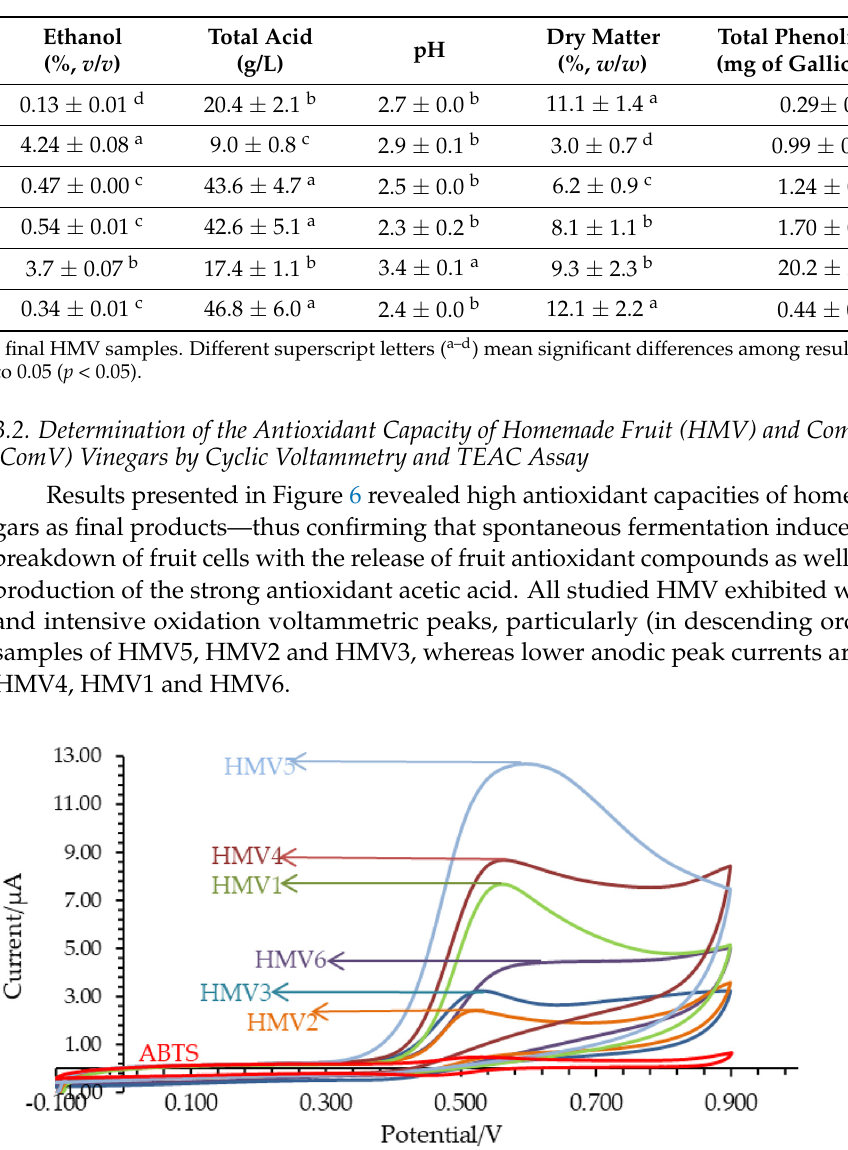
Table 1. Chemical composition of final homemade fruit vinegars (HMV) after two months (60 d) of fermentation, for ethanol content (% v / v ), total titratable acids (g/L), pH and dry matter (%, w / w ): apple vinegar (HMV1); raspberry vinegar (HMV2); blueberry vinegar (HMV3); blackberry vinegar (HMV4); rose hip vinegar (HMV5); persimmon vinegar (HMV6). The results were expressed as mean values and standard deviations (mean ± STDV) and calculated from one/two replicates of each fermentation and three analytical measurements.